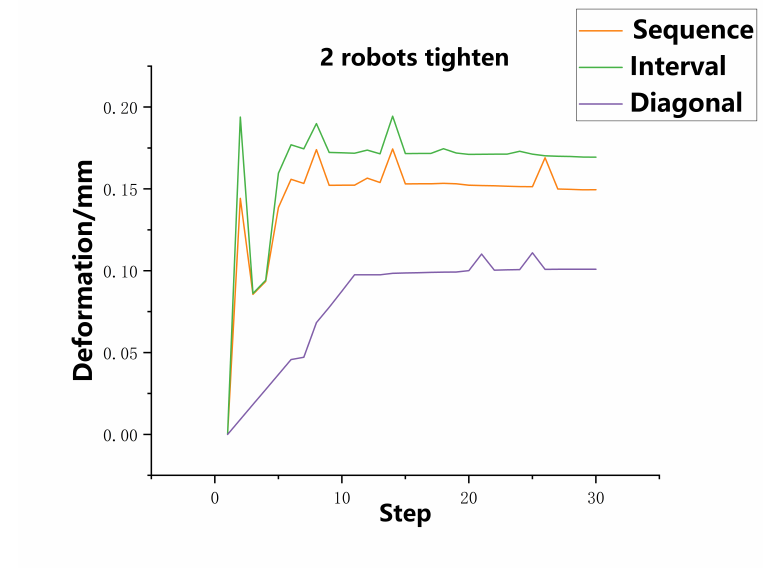
Figure 14. Deformation of two robots tightening aerospace